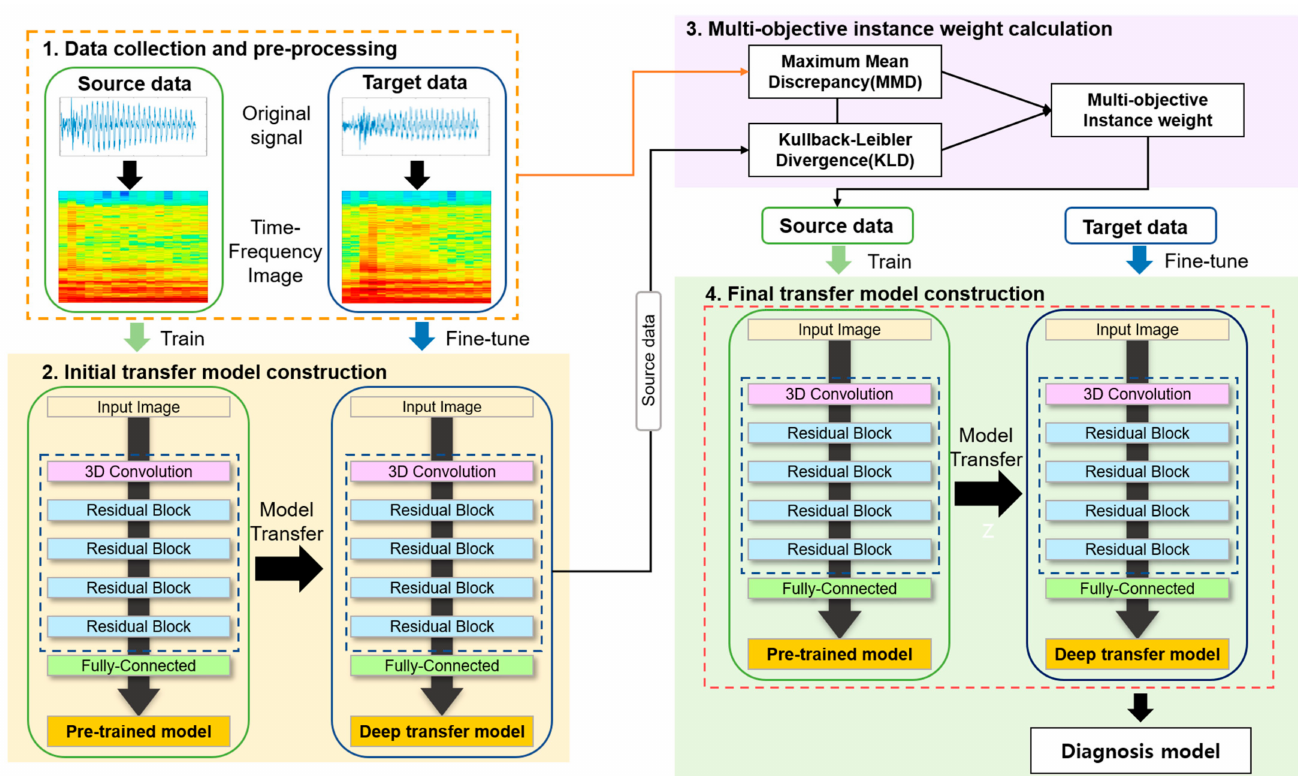
Figure 1. Detailed procedure of the proposed multi-objective instance weighting-based deep transfer learning network (MOTL)